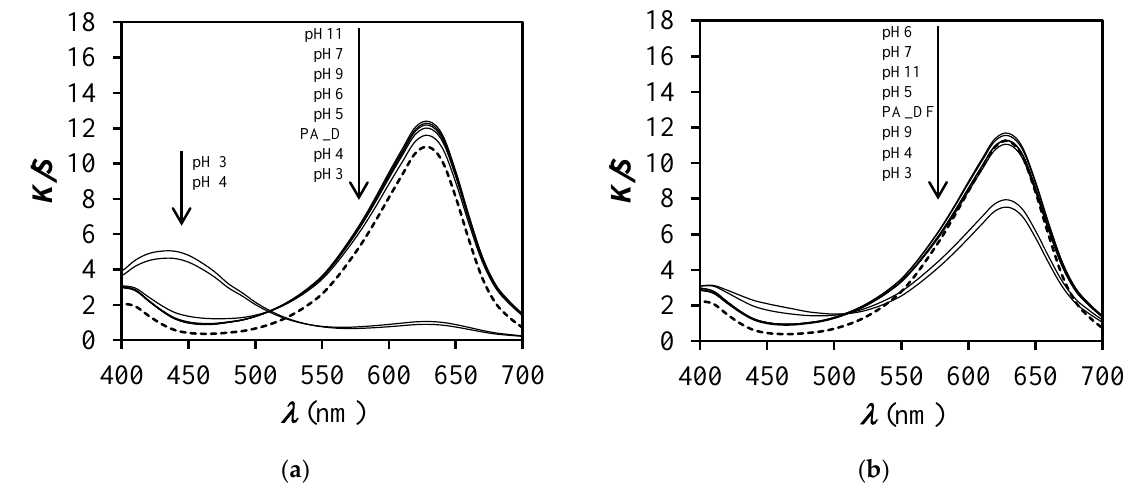
Figure 6. K/S values vs. wavelength ( λ ) for unfinished ( a ) and finished ( b ) samples, dyed with dye concentration of 0.2% o.m.f., before (dotted line) and after immersion (solid line) in buffer solutions of different pH values.